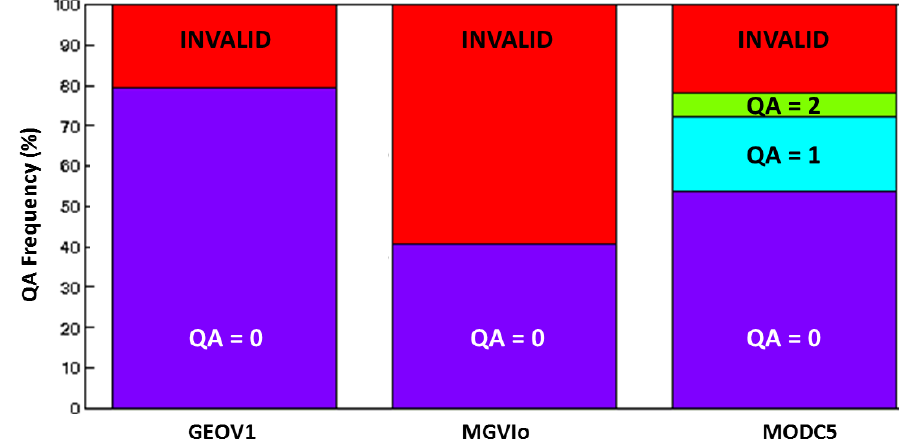
Figure 2. Distribution of the occurrence of QA values for each product (GEOV1, MGVIo, MODC5). QA = 0 is the best estimate while the highest QA value for each product corresponds to invalid product. Computation is performed over the BELMANIP2.1 sites (49 × 49 km 2 ), during the periods defined in Table 2, and for the original temporal sampling.